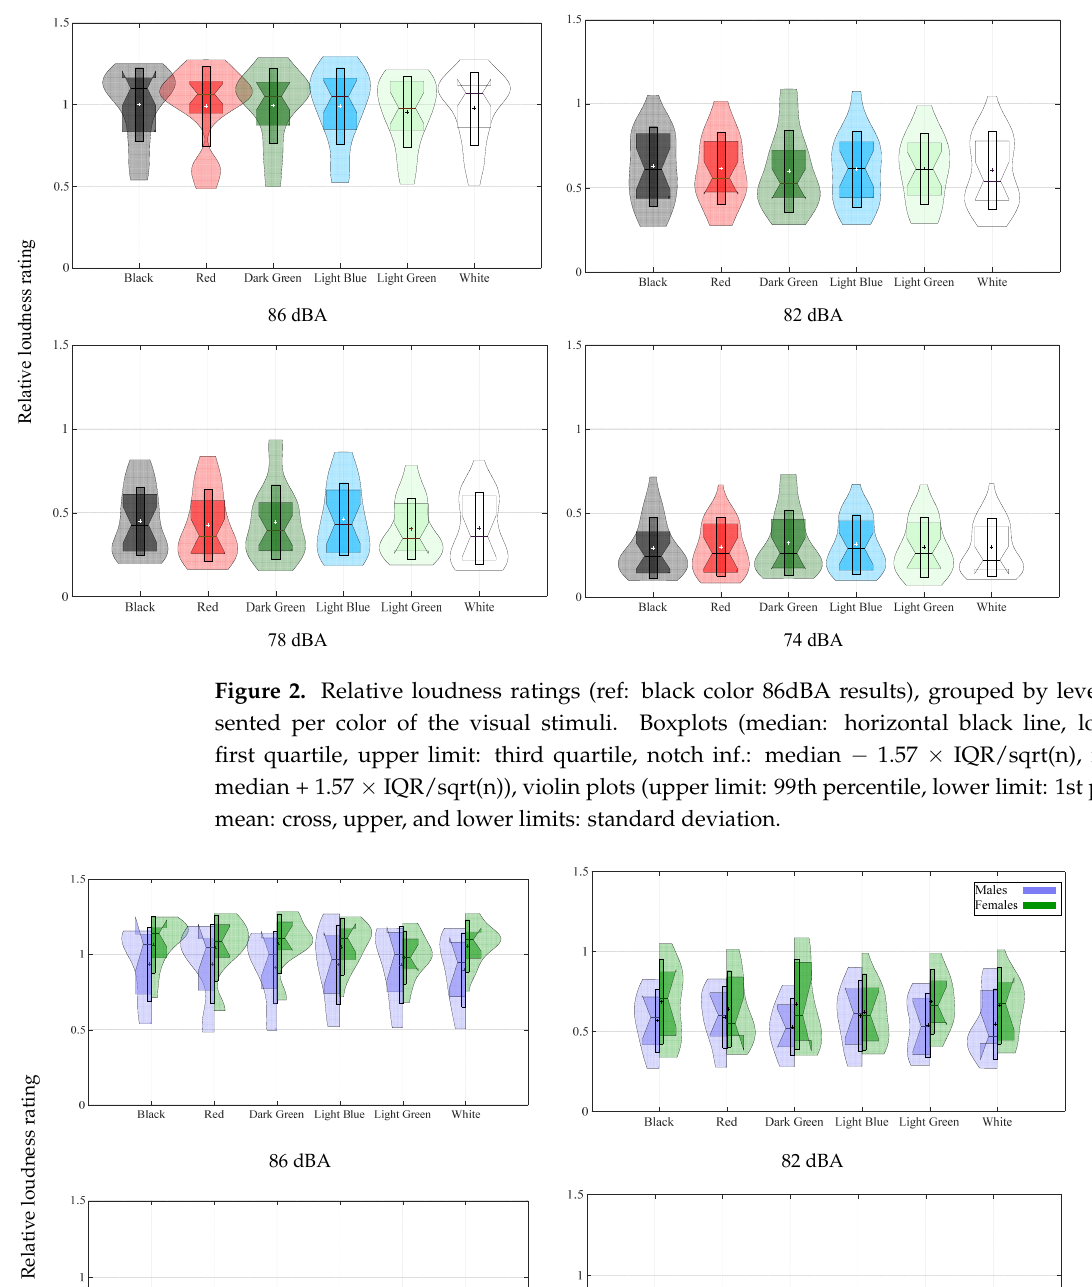
Figure 3. Relative loudness ratings (ref: black color 86dBA results), grouped by level and presented per gender and per color of the visual stimuli. Boxplots (median: horizontal black line, lower limit: first quartile, upper limit: third quartile, notch inf.: median − 1.57 × IQR/sqrt(n), notch sup: median + 1.57 × IQR/sqrt(n)), violin plots (upper limit: 99th percentile, lower limit: 1st percentile), mean: cross, upper, and lower limits: standard deviation.